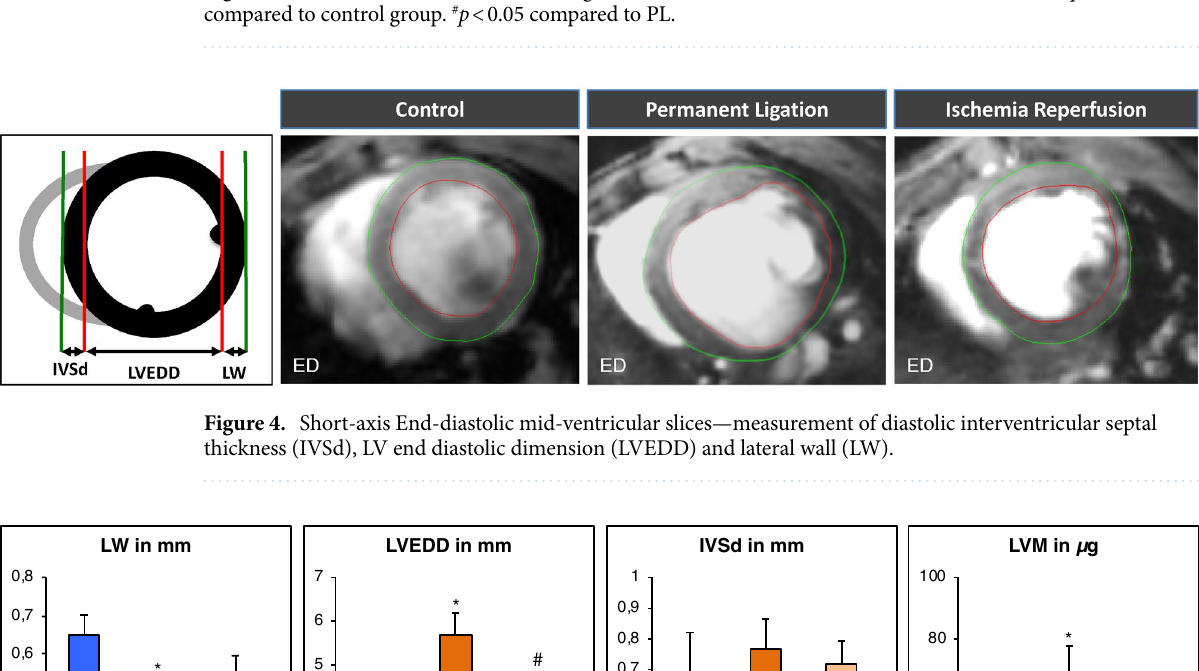
Figure 3. Volumetric and functional changes 3 weeks after MI induction. Values are mean ± SD. * p < 0.05 compared to control group. # p < 0.05 compared to PL.